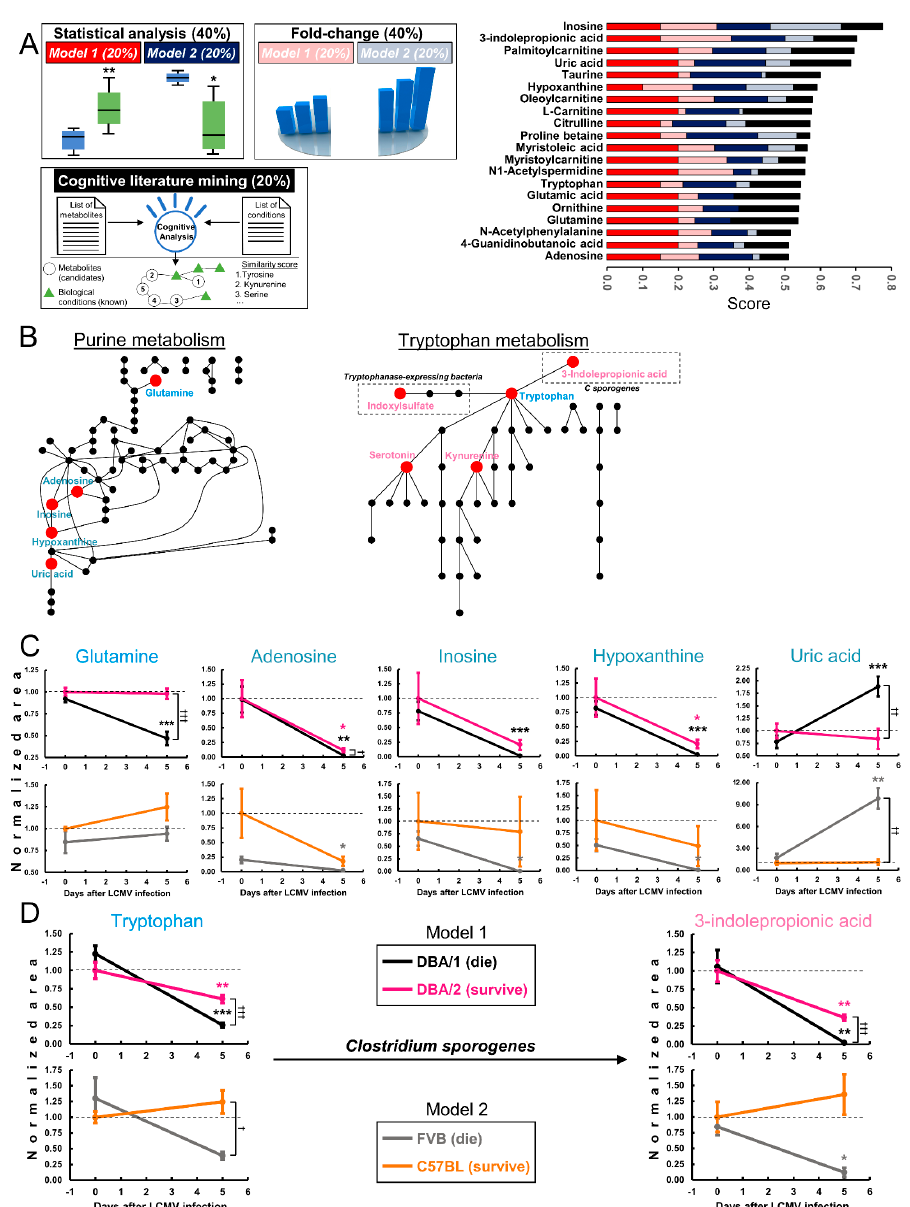
Figure 2. 3-IPA and purines were prioritized as candidates to modulate immune responses to LCMV infection. ( A ) Metabolite candidates prioritized and chosen using a weighted algorithm